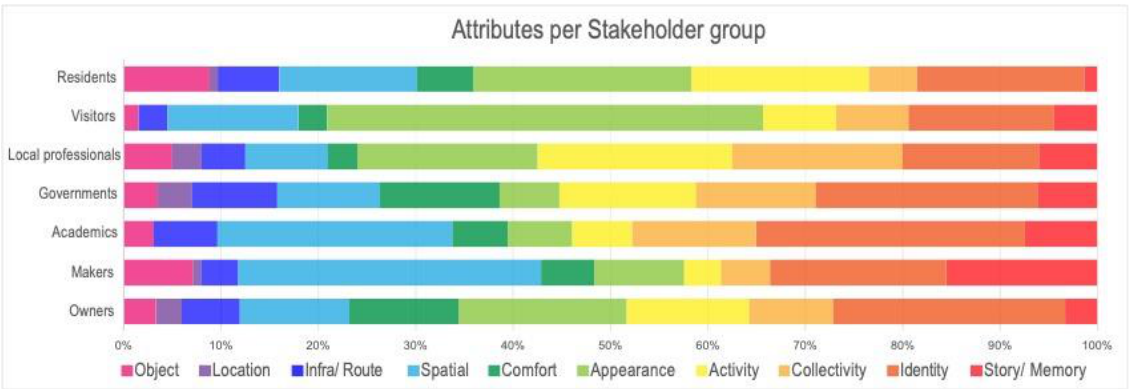
Figure 5. Attribute categories mentioned per stakeholder group. The chart shows attribute categories as a percentage of the total of quotations of a stakeholder group.